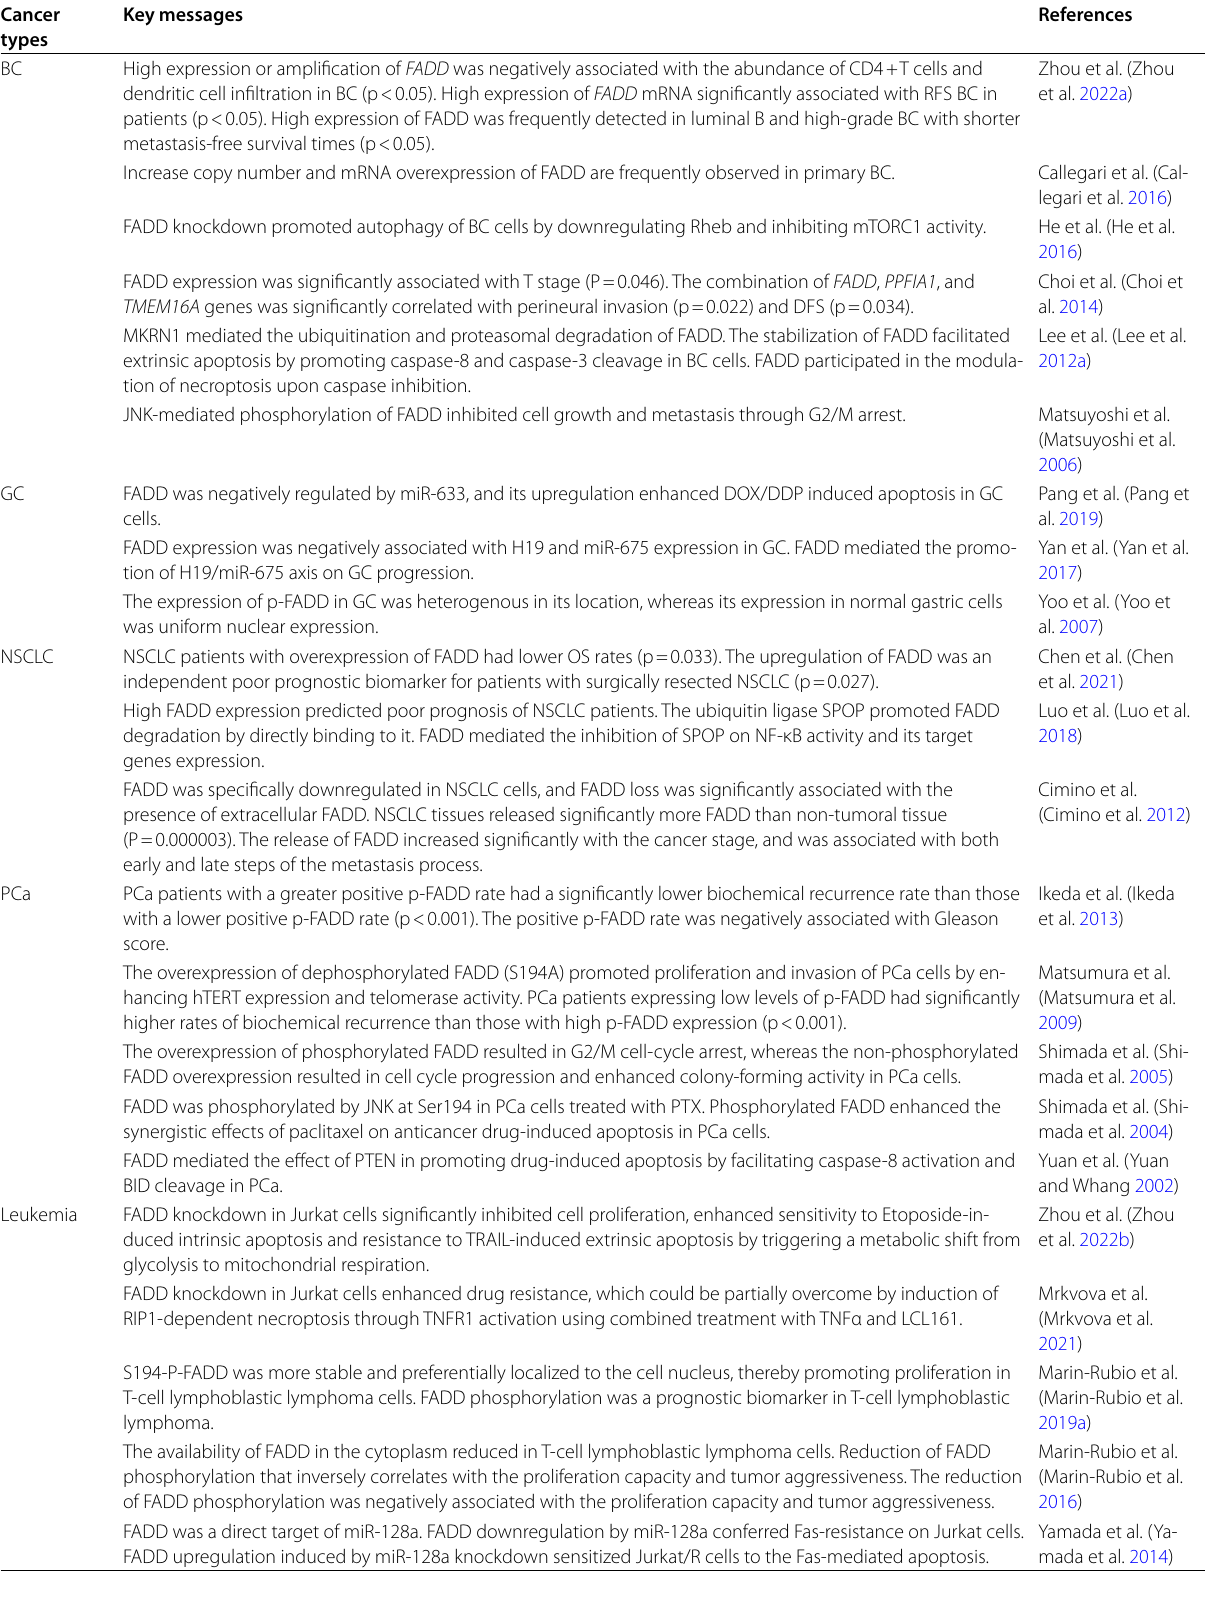
Table 2 Functional roles of FADD in different types of